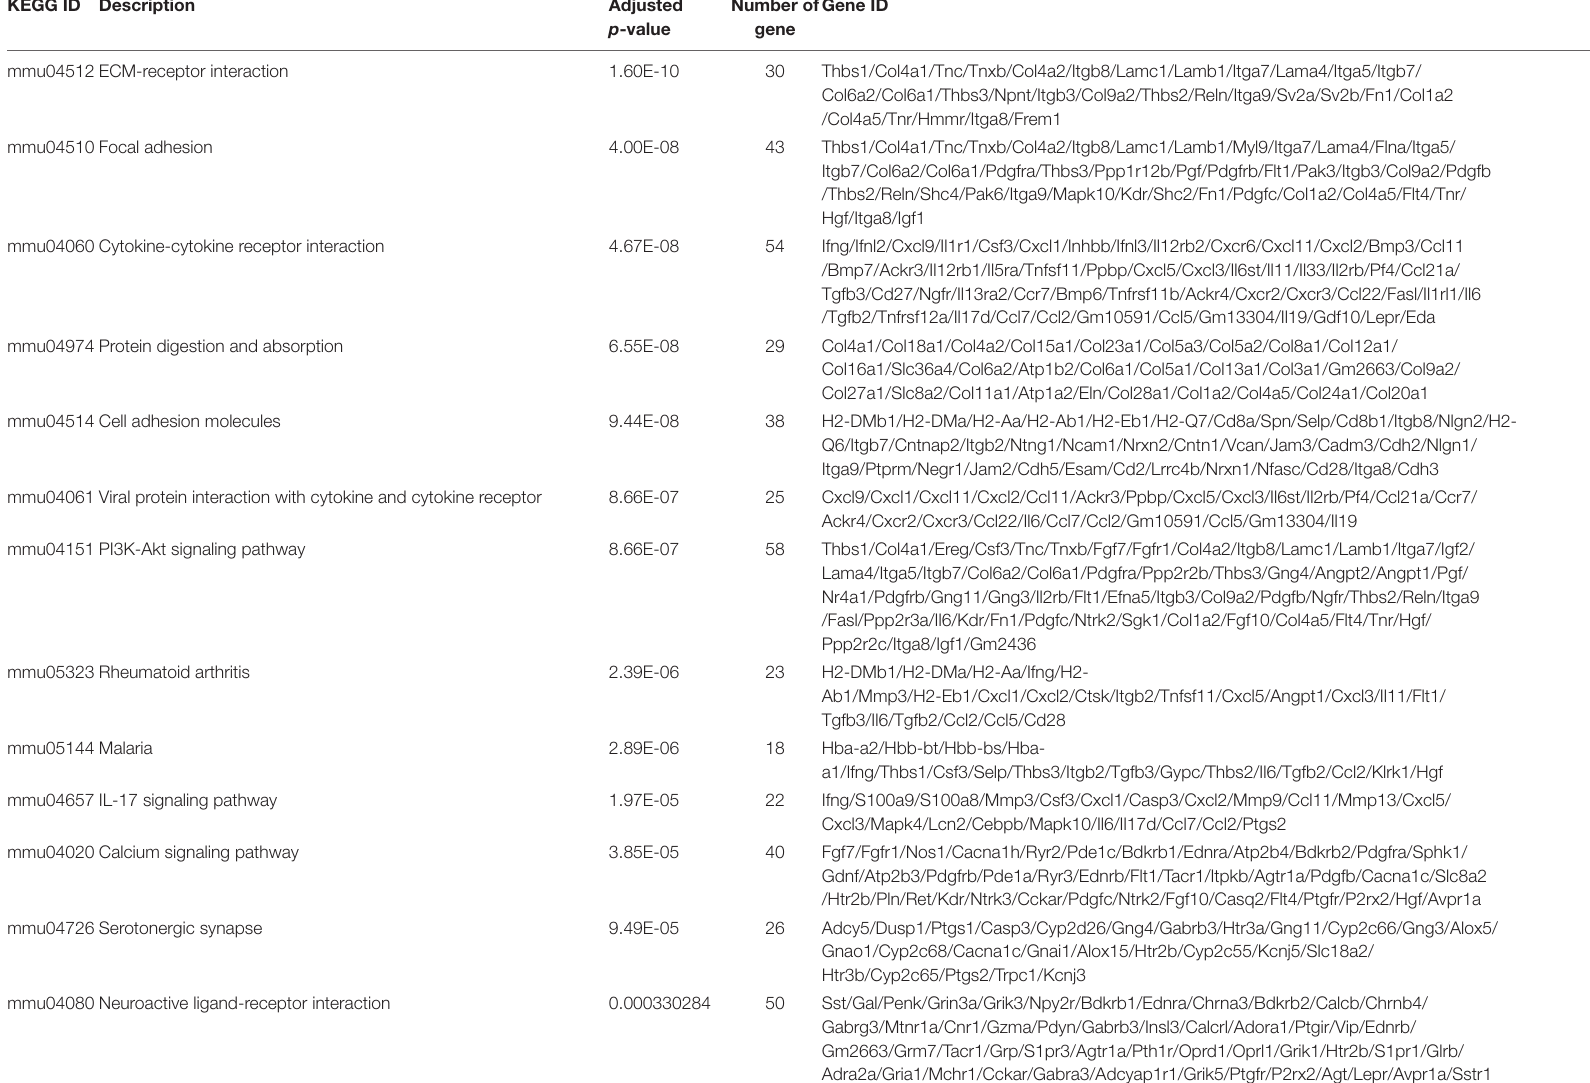
TABLE 4 | Effects of Mesalazine on the DSS-altered cell signaling